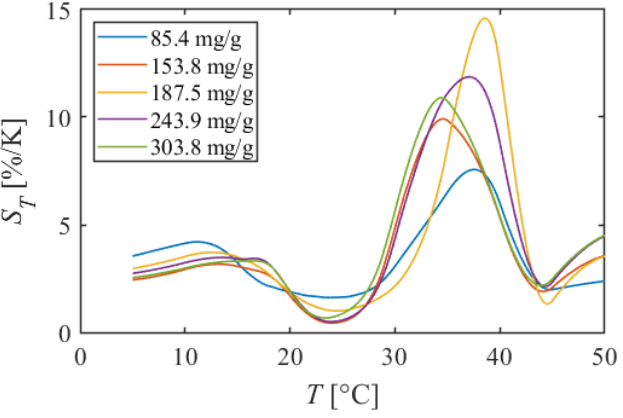
Figure 9. Temperature sensitivities of PMMA + EtOH + DCM in different dye concentrations.